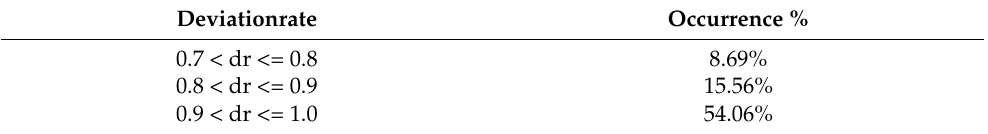
Table 2. Left column: intervals of the deviation rate (between 0 and 1); right column: percentage of occurrence or percentage of planes in the test set that fall within each interval